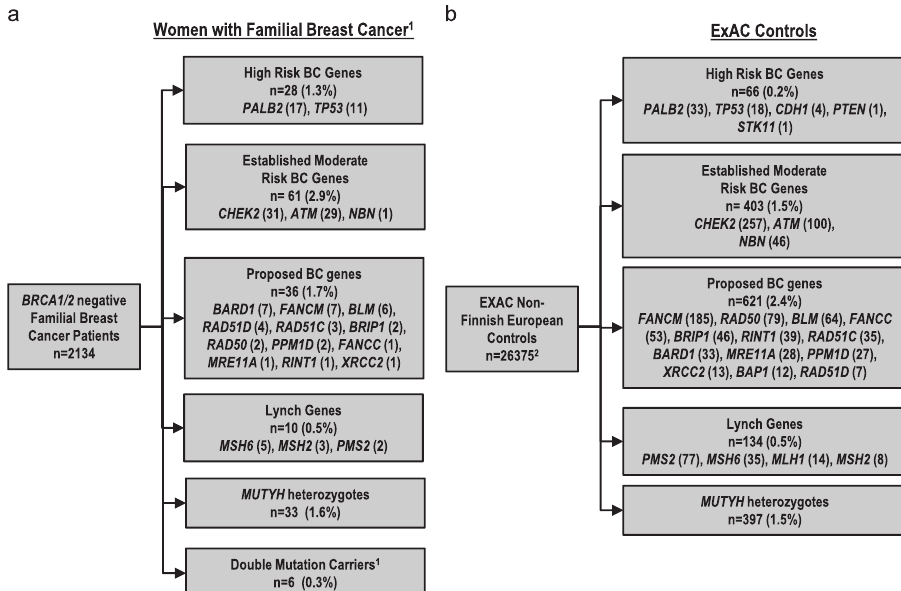
Fig. 2 Spectrum of mutations in 26 genes in familial breast cancer women compared to Exome Aggregation Consortium (ExAC) controls. Rates of truncating, known pathogenic missense mutations, and copy number variants in ( a ) BRCA1/2 negative familial breast cancer women analyzed by targeted sequencing and ( b ) analysis of ExAC data (excluded copy number variation). Sequencing data was analyzed for mutations in high risk breast cancer genes, moderate risk breast cancer genes, proposed breast cancer genes, the Lynch syndrome genes, and MUTYH . 1 Women with two pathogenic mutations were removed from single gene counts and include two cases with ATM/CHEK2 mutations, two with CHEK2/PALB2 mutations, and one patient each with ATM/RAD50 , and MSH6/RAD50 mutations. 2 Denominator for ExAC non-Finnish European controls (The Cancer Genome Atlas excluded) was determined by averaging the allele number for each identi fi ed variant and dividing by